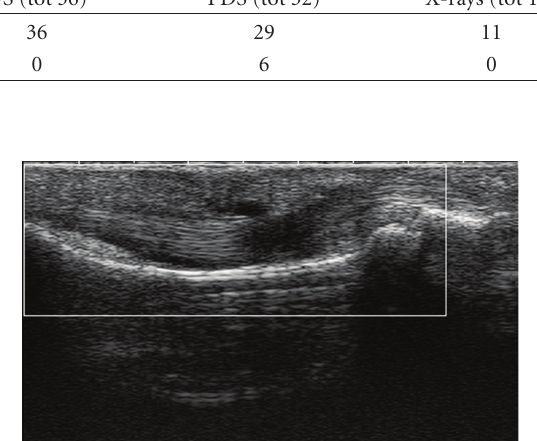
Figure 1: US scan. Index finger flexor tenosynovitis with fluid and thickening, suggesting PsA.